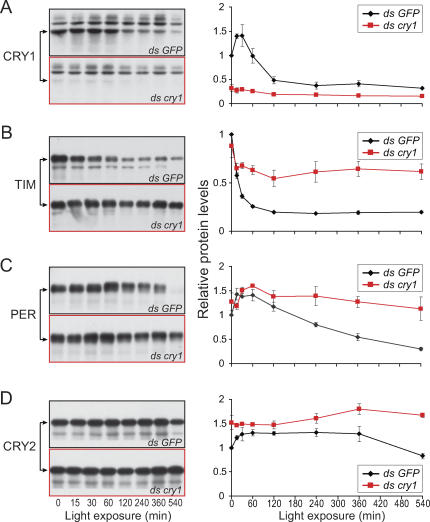
CRY1 and TIM Reponses to Light in DpN1 CellsClock protein abundance in LD-cultured cells changes in response to light. DpN1 cells were cultured under LD, pretreated with dsRNA against GFP (black lines) or dsRNA against cry1 (red lines), and then exposed to light (at the start of the normal light period) for 540 min. Cells were collected at the designated times. Cell homogenates were analyzed by Western blot, and probed for CRY1 (GP37), TIM (GP47), PER (GP40), and CRY2 (GP51) (left-hand panels). The time courses of declines were quantified by chemiluminescence, and band intensity was normalized against α-tubulin (right-hand panels). (A) CRY1, (B) TIM, (C) PER, (D) CRY2. Time 0 is before lights on. Each point is the mean ± SEM of three experiments.